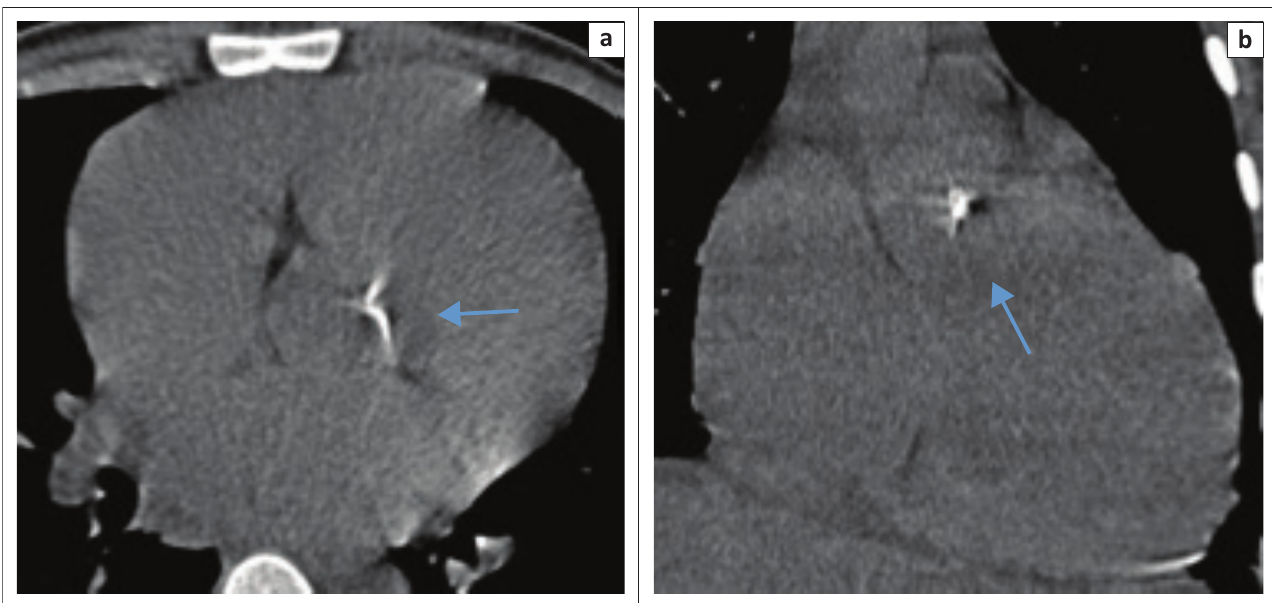
FIGURE 1 : Axial (a) and coronal (b) precontrasted images through the mediastinum depicting dense calcium deposition on the aortic valve as indicated by the